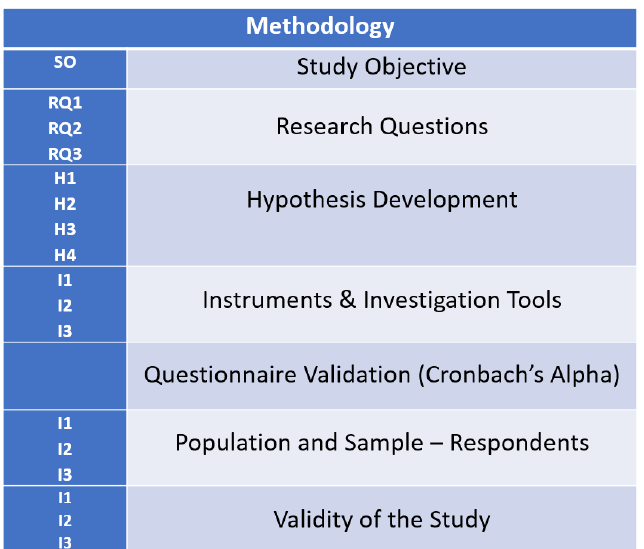
Figure 3. Research design structure.